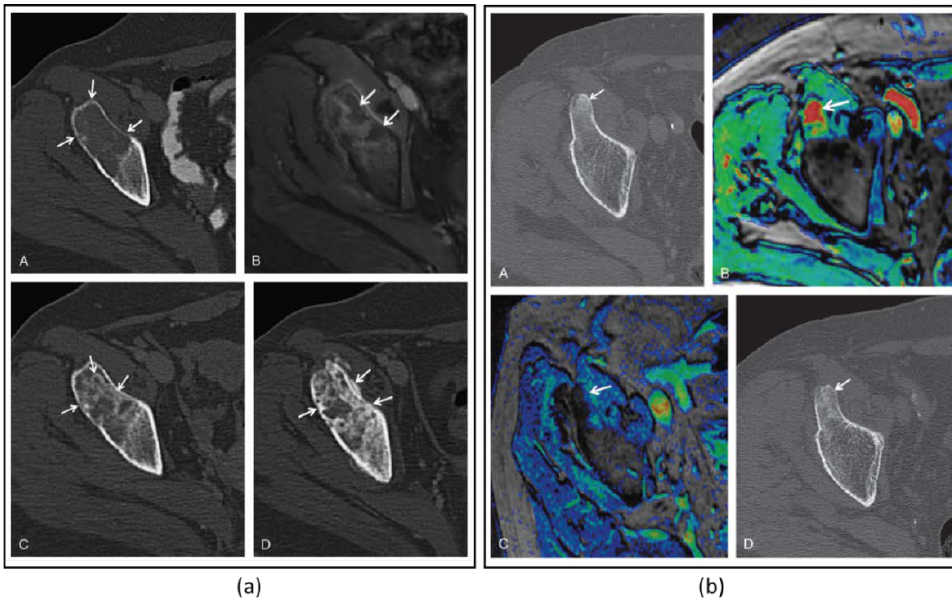
Figure 4. ( a ) Images of a 64-year-old woman with iliac bone metastasis from breast cancer. A: Axial CT image shows a wide lytic lesion located in the right anterior superior iliac spine (arrows) with evidence of focal cortical erosion, causing severe pain (pain severity score, 10). B: Axial contrast enhanced T1-weighted MRI (CE-MRI) after the MR-HIFU treatment shows the presence of some small areas of NPV (arrowheads) inside the lesion and at the periosteal margin. C: At the 2-month follow-up, axial CT identified the presence of some focal areas of de novo mineralization inside the treated tissue with partial restoration of cortical borders (arrowheads). D: At 3 months after the treatment, the lesion showed further denovo remineralization of the ablated tissue (arrowheads). On the basis of MDA criteria, this patient was classified as a partial responder; pain severity score dropped to 0 throughout the follow-up period. ( b ) Axial CT image of a 63-year-old man with primary prostate cancer. A: The arrowhead shows a metastasis located in the right anterior-superior iliac spine with a hyperdense pathologic nodular nucleus. B: The color-coded T1-weighted CE-MRI acquired reveals intense enhancement of the pathologic area (arrow). At 3 months after the MR- HIFU treatment, CE-MRI (C) showed a marked reduction of the lesion enhancement (arrow). D: The axial CT image acquired the same day reveals increased density in the treated area and the disappearance of the nodular pathologic tissue (arrow). On the basis of the MDA criteria, this patient was classified as a complete responder. Figures adapted and reprinted with permission from Napoli A, Anzidei M, Marincola BC, Brachettti G, Ciolina F, Cartocci G, Marsecano C, Zaccagna